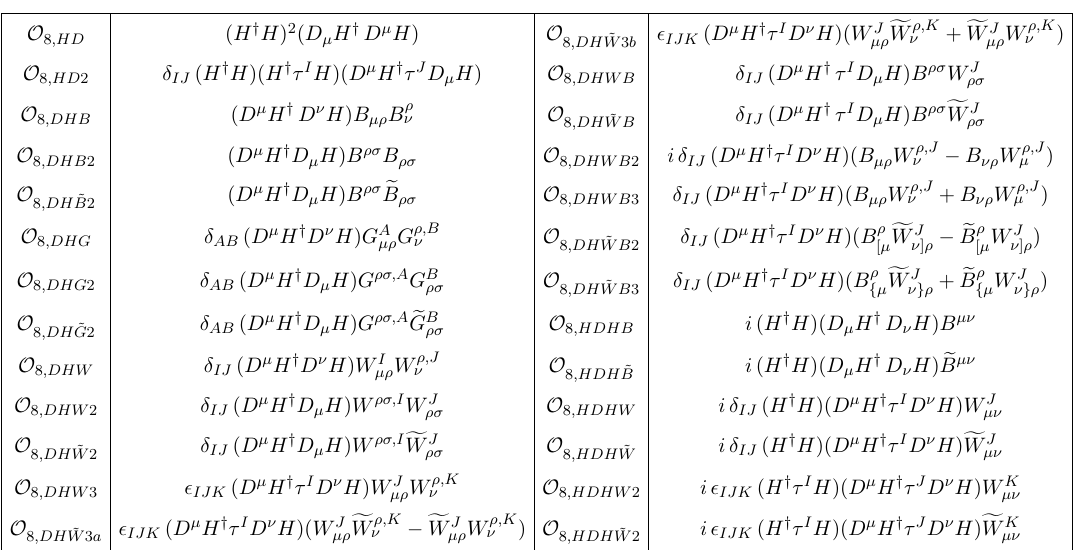
Table 5 . The 26 two-derivative operators after conversion to the standard X , e X notation (plus linear combinations). Factors of i are included where necessary so that the operators are explicitly self-hermitian with real